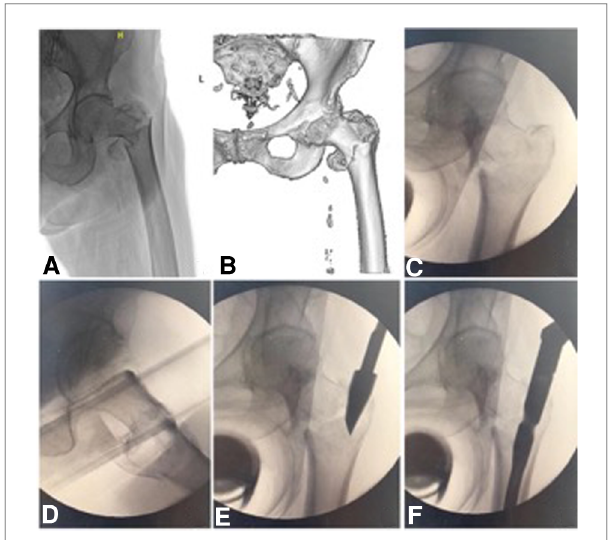
FIGURE 1 An 81-year-old woman with a comminuted intertrochanteric fracture, involving the medial arch and lateral wall was graded as AO/OTA 31- A2.2 (2018 edition). Preoperative x-ray ( A ) and CT scan ( B ) show the comminuted intertrochanteric fracture. ( C,D ), anteroposterior and lateral images show that the reduction was acceptable under axis traction. ( E,F ) The entry point was con fi rmed, and the displaced medial arch fragments developed after the femoral nail